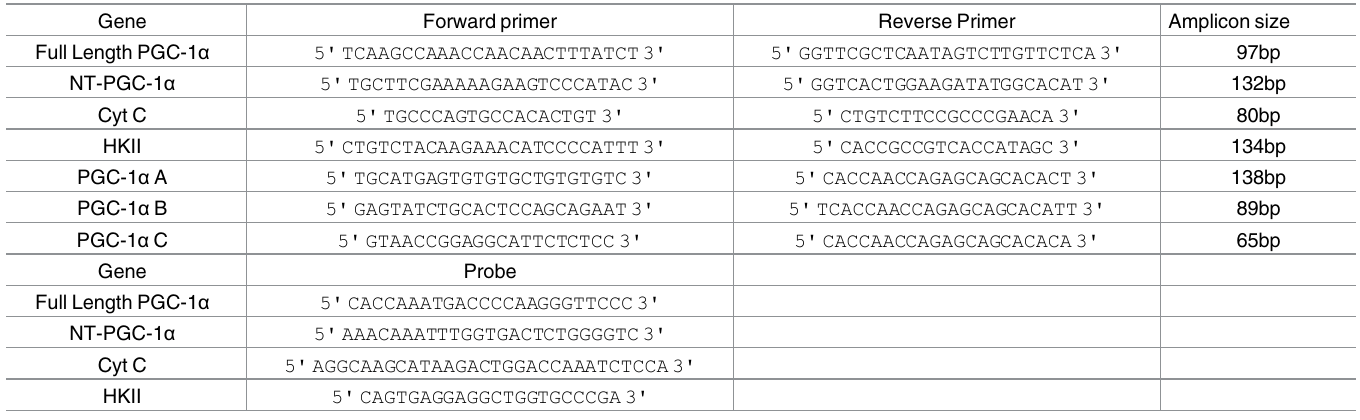
Table 1. Primer and probe sequences used for real-time